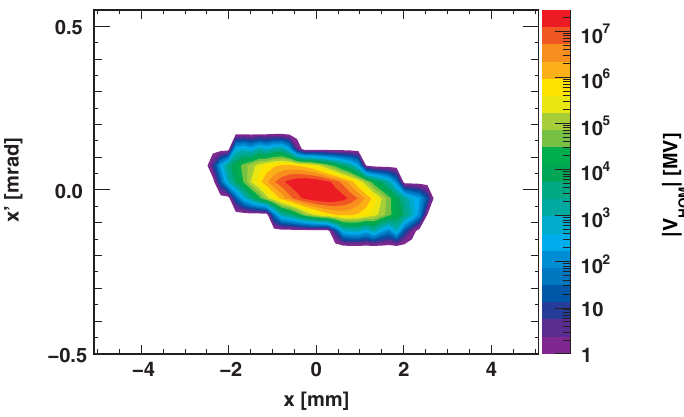
FIG. 27. Average (black) and maximum (red) transverse HOM voltage present in the cavities after two pulses for 1000 linacs. Settings: N ¼ 1000 , see Table